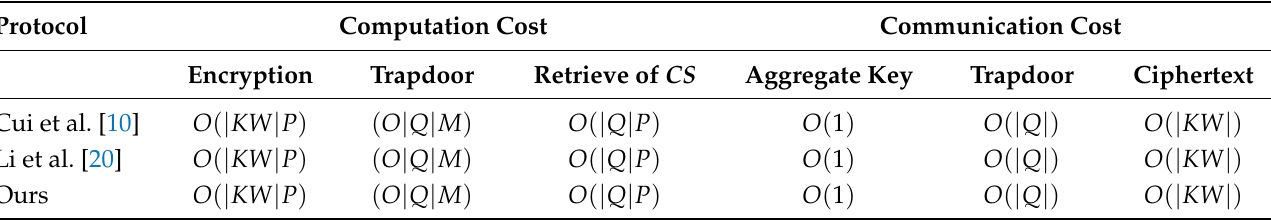
Table 5. Comparison of